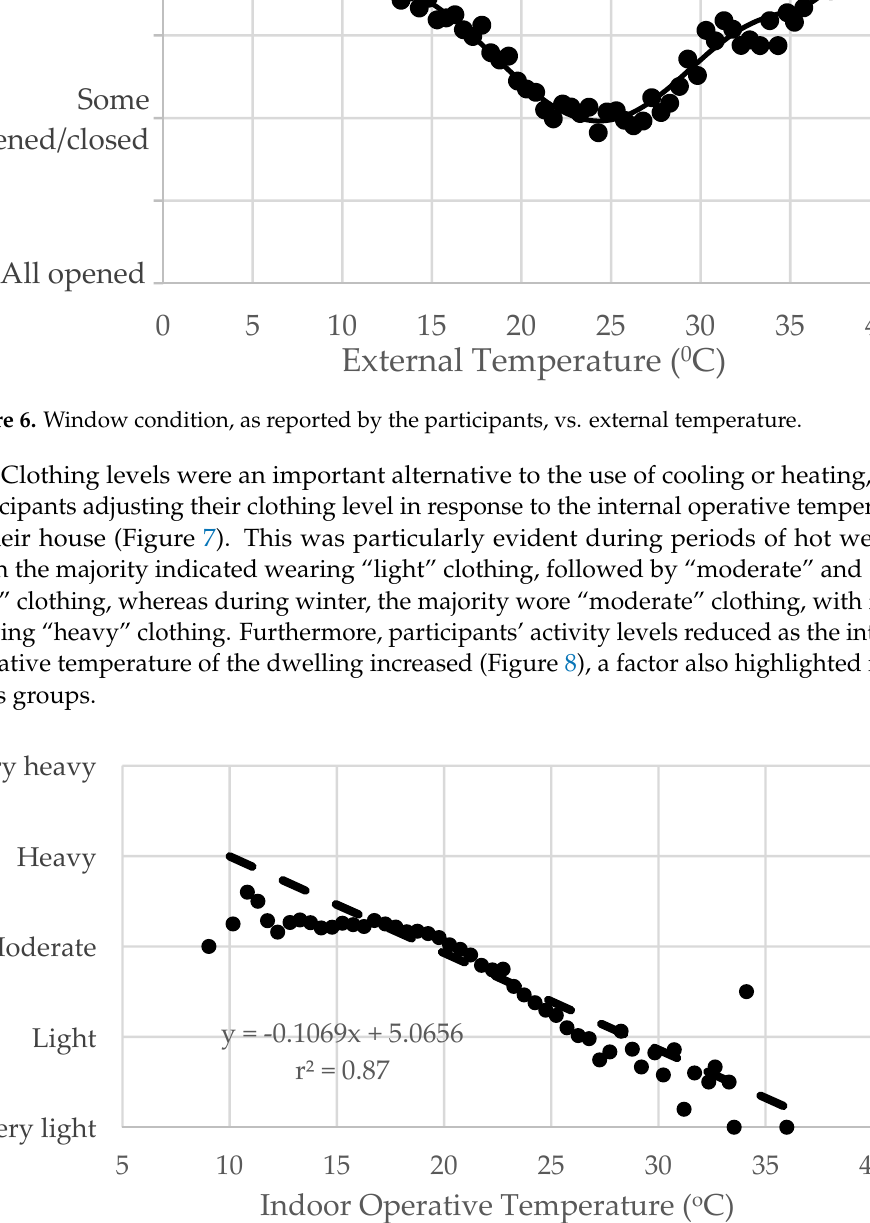
Figure 8. Activity level, as reported by the participants, vs. indoor operative temperature. 4. Discussion Sustainability, energy efficiency and healthy ageing communities are growing areas of concern as the world faces a changing climate and an ageing population. These issues have been identified by the United Nations, which has deemed “Sustainable Cities and Communities” to be one of its 17 Sustainable Development Goals [47]. This study helped to address these goals by using a collaborative approach to investigate influences of ther- mal conditions on the health of older people. 4.1. Thermal Environment, Behaviour and Health Specifically, in this study, we aimed to investigate if the thermal environment of housing affected the self-reported health and wellbeing of older people in three climate zones of South Australia over a period that included record-high temperatures. The anal- ysis of extracted health-related data from previous stages of the research suggested a non- negligible effect of high and low indoor temperatures on the health of older occupants. Notably, there was a strong correlation between the thermal sensation and self-rated health, with the highest ratings for health and wellbeing occurring in conditions that pro- vided optimal thermal comfort and satisfaction. By contrast, health and wellbeing were perceived to worsen when indoor temperatures were below 15 °C or above 28 °C. Indeed, the non-linear relationships seen between self-reported health and the internal operative temperature (Figures 3 and 4) were somewhat similar to the U- or J- shaped relationships